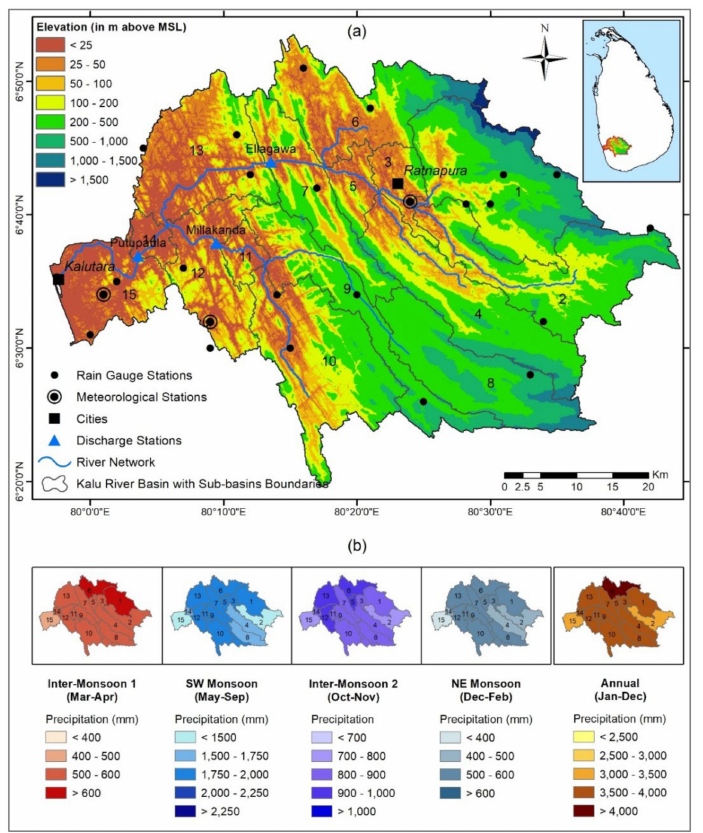
Figure 1. Kalu River Basin, Sri Lanka ( a ) and spatial distribution of seasonal and annual variations in precipitation over the basin for the period of 1990–2015 ( b ). MSL: mean sea level, SW: southwest, and NE: northeast. Precipitation of each of the sub-basins was obtained from interpolated gauge data (more details in Section